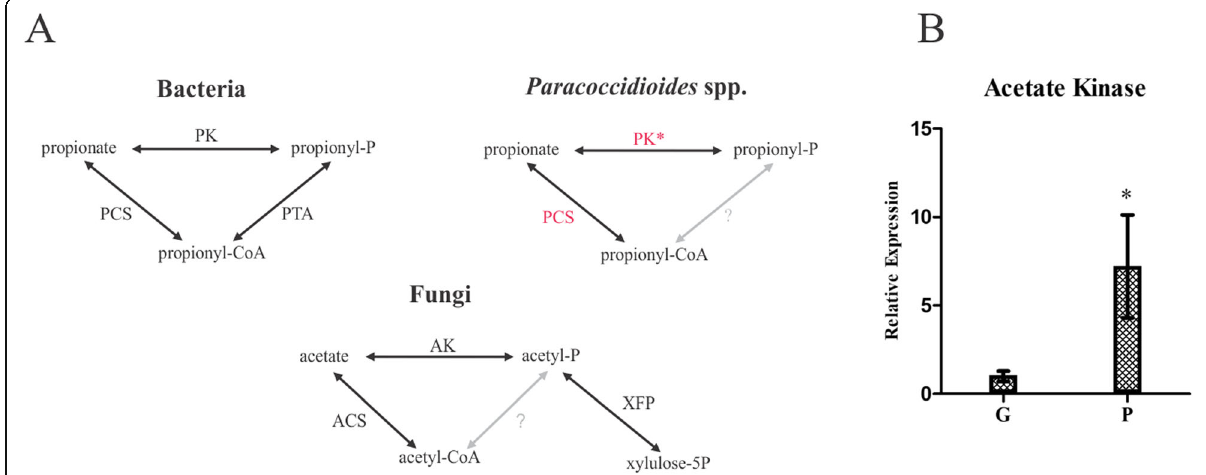
Fig. 8 Roles of propionate and acetate kinases in acetate or propionate activation. a - AK acetate kinase, PK propionate kinase, PTA phosphotransacetylase, XFP d-xylulose-5-phosphate phosphoketolase, PCS propionyl-CoA syntethase. * Putative propionate kinase found only in propionate condition. b - Transcript levels of acetate kinase in yeast cells grown in glucose (G) or propionate